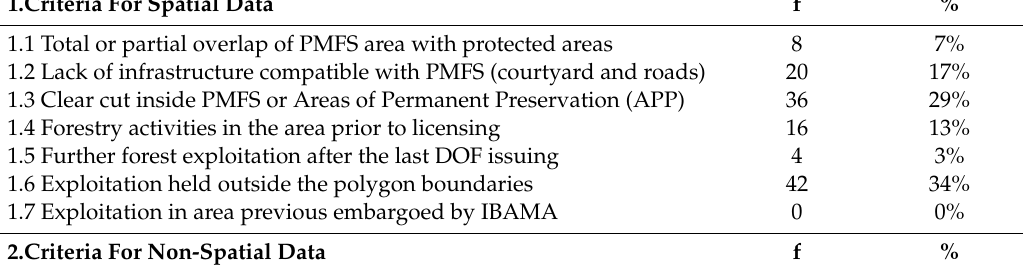
Table 3. Frequency (f) and percentage (%) of irregularities / signs of